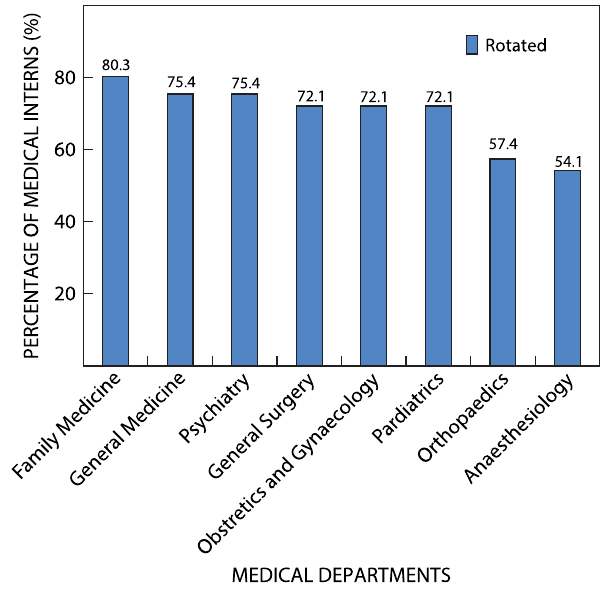
Figure 1: Percentage of medical interns who completed their rotation in the different departments ( n = 61).